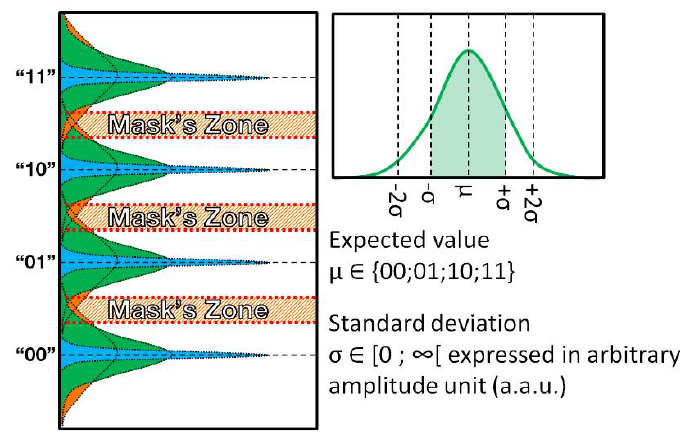
Figure 2. Gaussian noise representation on each PAM4 level for different standard deviations (blue: low standard deviation; green: medium; orange: high).